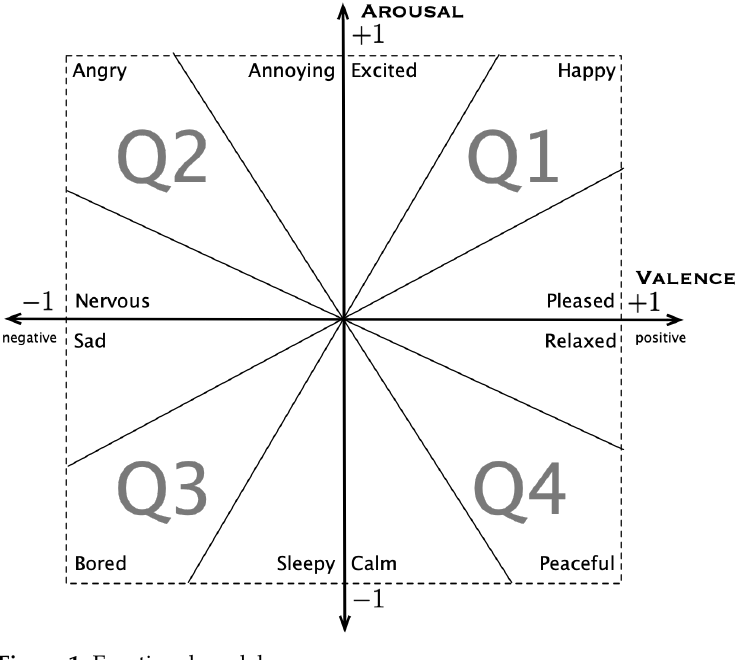
Figure 1. Emotional model. Three emotions are located in each quadrant. The first quadrant (valence and posi- tive arousal) is made up of emotions: excited, happy and excited. The second quadrant (negative valence and positive arousal) includes the emotions annoying, angry, and ner- vous. The third quadrant emotions (valence and negative arousal) are sadness, boredom, and sleepiness. Finally, the last quadrant (positive valence and negative arousal) contains the emotions calm, peace and relaxation. According to this, the emotional space is made up of twelve